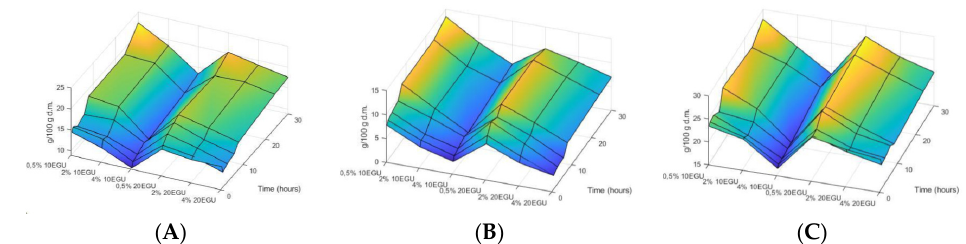
Figure 1. HPLC-RID analysis of ( A ) polysaccharides, ( B ) oligosaccharides ( C ) and simple sugars released from apple by-product during enzymatic treatment with Celluclast ® at atmospheric pressure. Data are expressed as g/100 g dry material. EGU: Endo-Glucanase Units.